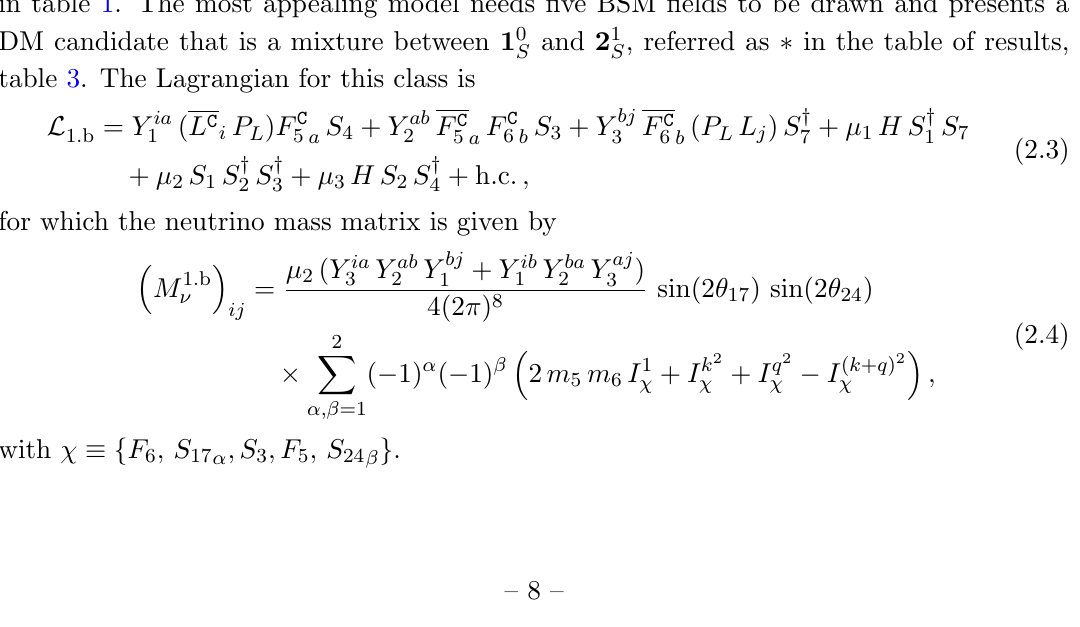
table 3. The Lagrangian for this class